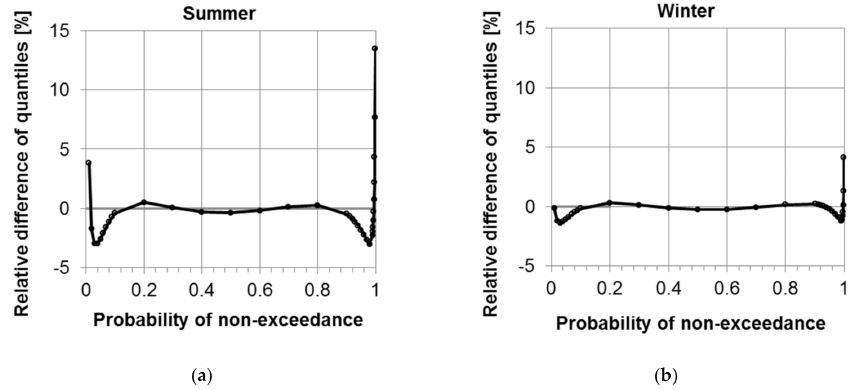
Figure 6. The di ff erence between quantiles of the same order in MF and MM approach expressed in (%) of MM value: ( a ) aggregated summer quantile; ( b ) aggregated winter